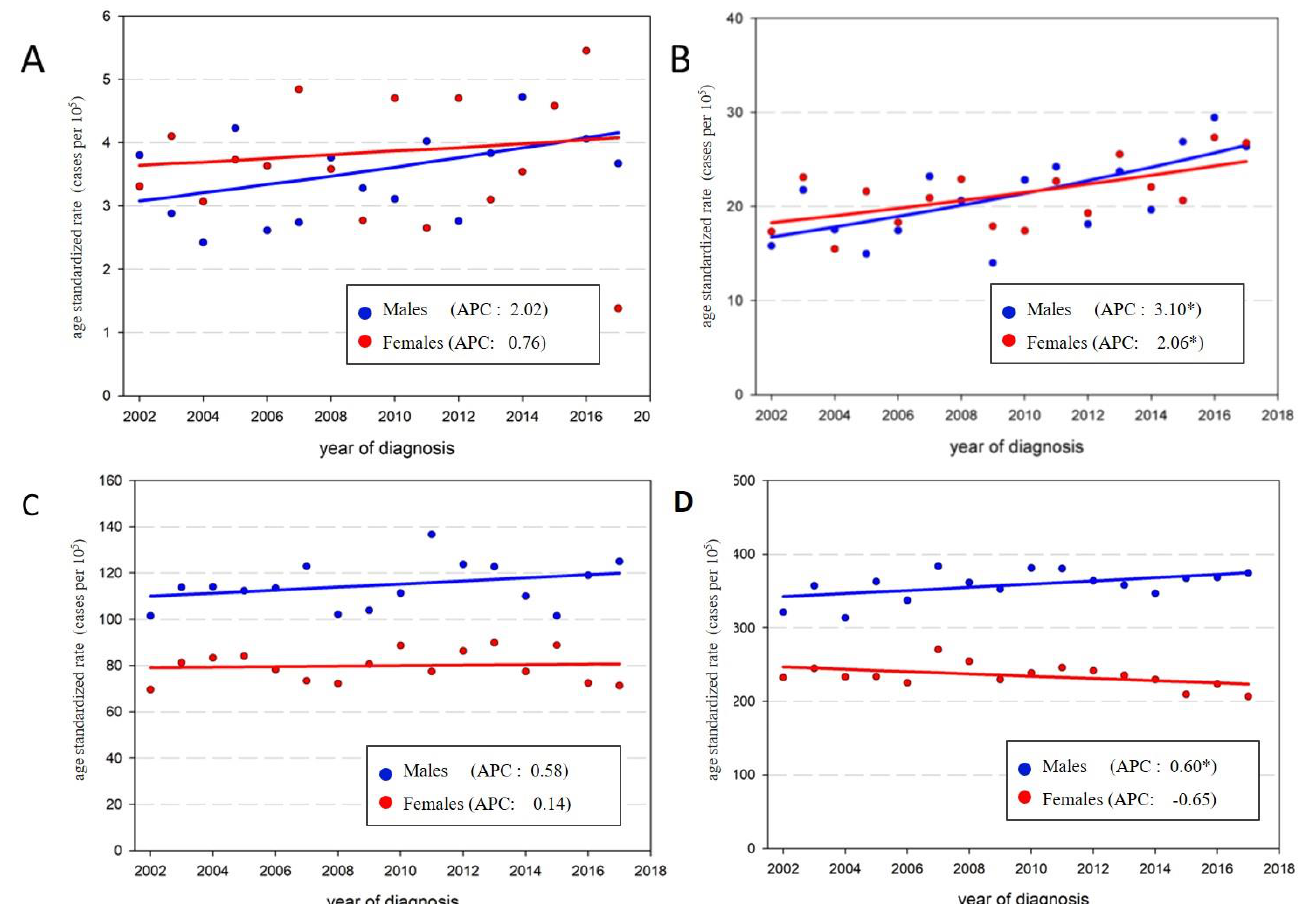
Figure 2. Age-specific colorectal cancer incidence and annual percentage change (APC) by sex and age groups, Uruguay, 2002–2017.( A ) 20 to 39 years, ( B ) 40–49 years, ( C ) 50–69 years, ( D ) 70 years and older; (* p < 0.05)